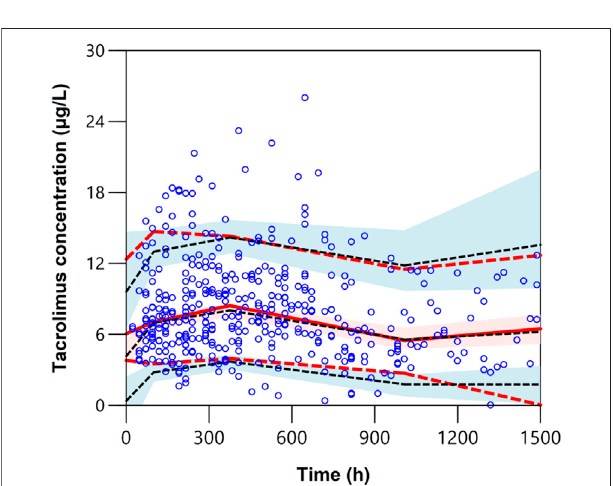
FIGURE 2 | Plot of the prediction-corrected visual predictive check ( n = 1,000). The blue dots are the measured concentrations. The dashed black lines represent the 10%, 50%, and 90% percentiles for the measured concentrations. The solid red line represents the median of simulated predictions by the fi nal model, and the semitransparent red shaded area represents the simulation-based 90% con fi dence interval for the median. The red dash lines represent the 10% and 90% percentiles of simulated concentrations, and the semitransparent blue shaded areas represent the simulation-based 90% CIs for the corresponding predicted percentiles from the fi nal model.